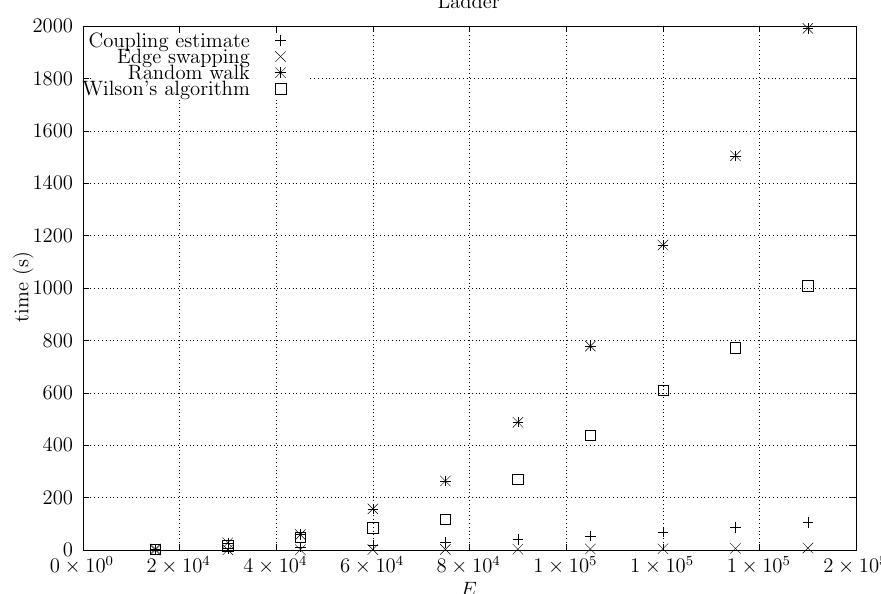
Figure 29. Running times for sparse (ladder) graphs averaged over five runs, including the running time for computing the optimistic coupling estimate, the running time for generating a spanning tree based on that estimate, the edge-swapping algorithm, the running time for generating a spanning tree through a random walk, and the running time for Wilson’s algorithm.